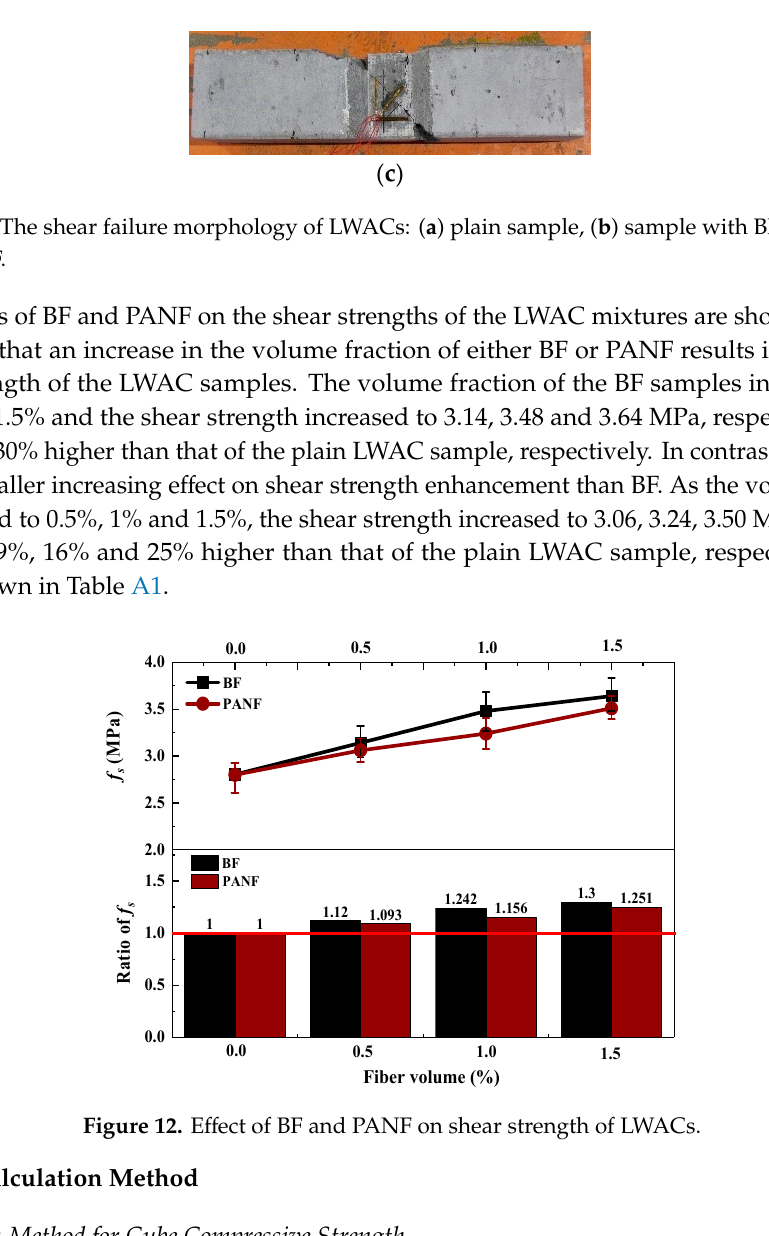
BF PANF Figure 9. Effect of fibers on flexural strength of LWACs. ( a ) ( b ) ( c ) Figure 10. The flexural failure morphology of LWACs: ( a ) plain sample, ( b ) sample with BF, ( c ) sample with PANF. 3.6. Shear Strength Figure 11 shows the shear failure morphology of the LWAC mixtures. As adding PANF and BF led to similar failure morphologies of the plain sample. When the loading reached approximately 80% of the shear capacity bearing, a crack occurred in the shear front. With loading continued, as the